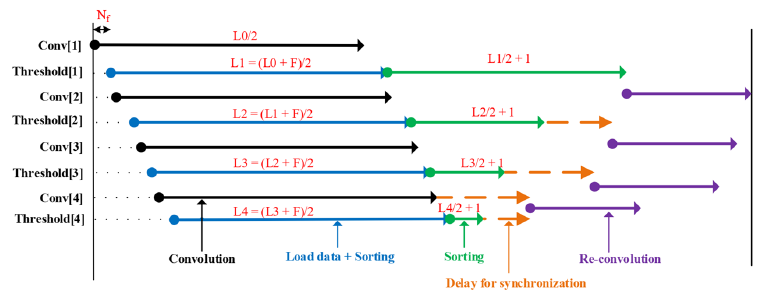
Figure 15. Timing diagram of Denoise IP